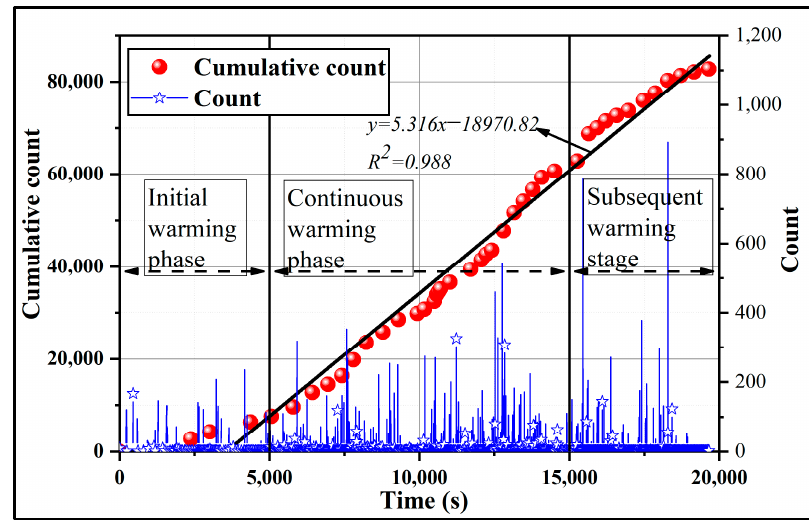
Figure 2. AE count and cumulative count plot.